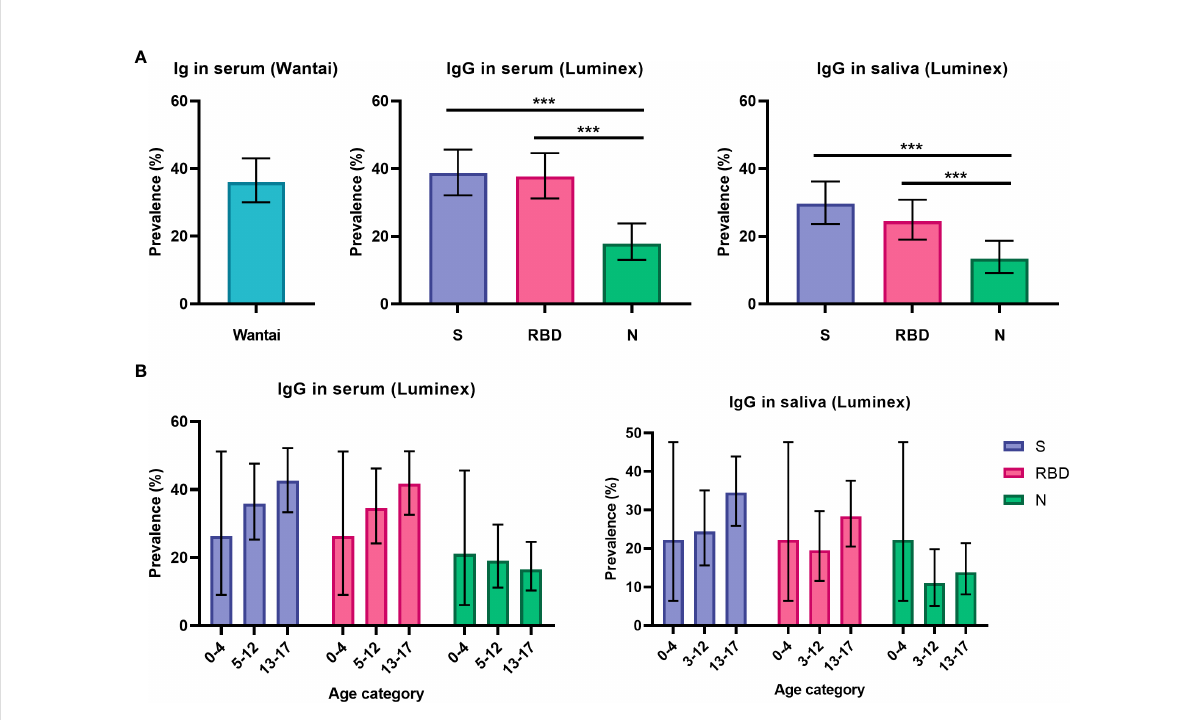
FIGURE 1 Prevalence of SARS-CoV-2 speci fi c antibodies in serum and saliva. (A) Prevalence estimates of RBD-speci fi c antibodies in serum using the Wantai assay (n = 209) and of S-, RBD- and N-speci fi c antibodies using the Luminex assay in serum (n = 212) and saliva (n = 216) for all children (total cohort n = 223). (B) Prevalence of S-, RBD- and N-speci fi c antibodies in all children, shown separately for pre-school children (0-4 years old, n = 19 for serum, n = 18 for saliva), primary school children (5-12 years old, n = 78 for serum, n = 82 for saliva) and secondary school children (13-17 years old, n = 115 for serum, n = 116 for saliva). Prevalence estimates are the calculated proportion with a value above the determined cut-off. Estimates are shown with 95% con fi dence intervals. McNemar test was used for differences between paired proportions. S, spike; RBD, receptor binding domain of the spike; N, nucleocapsid; *** = P ≤